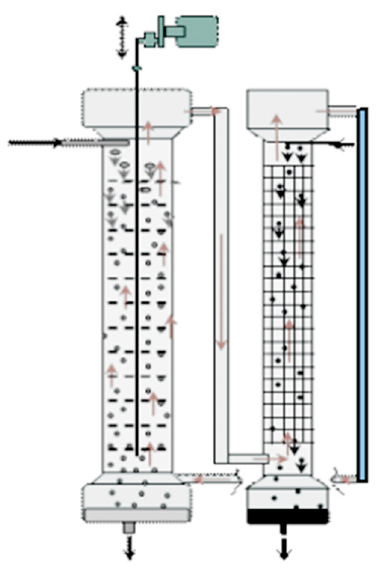
Figure 6. Schematic principles of the operation of the two-column three-phase extraction apparatus with forced circulation of the membrane phase and countercurrent flows of phases in both columns. Red arrows—circulation of the membrane phase; black arrows—flows of the aqueous phases.